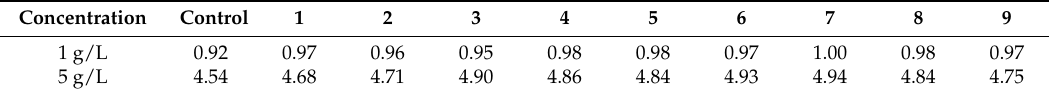
Table 4. K / S values of 1 g/L and 5 g/L pigment-dyed cotton